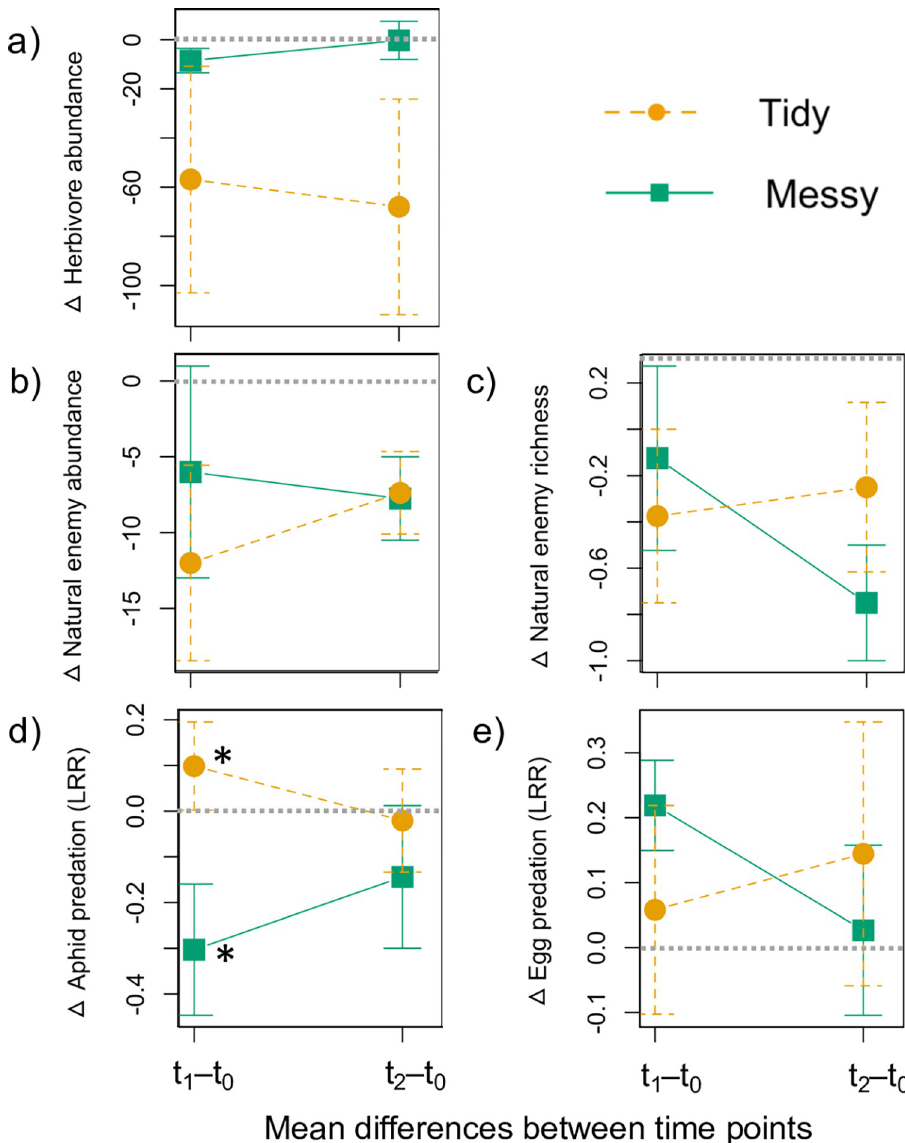
Fig 2. Trends in the changes ( Δ ) in herbivores (a), natural enemies (b, c), and pest predation (d, e) between the first and second observations. Graphs show raw value means across the 16 beds within each treatment area in each of the eight gardens. Positive values indicate a higher response variable value after the experiment, whereas negative values indicate a lower response variable value. Gray dashed horizontal lines indicate no change between time points. Error bars represent standard errors (SE) of the means of all data points (garden bed observations). Time points include before experimental manipulation (t 0 ), three days after the manipulation (t 1 ) and seven days after the manipulation (t 2 ). Asterisks ( � ) indicate significant differences between treatments at a respective time point tested using Mann- Whitney-Wilcoxon Tests (Significance: ‘ � ’ 0.05, ‘ �� ’ 0.01, ‘ ��� ’